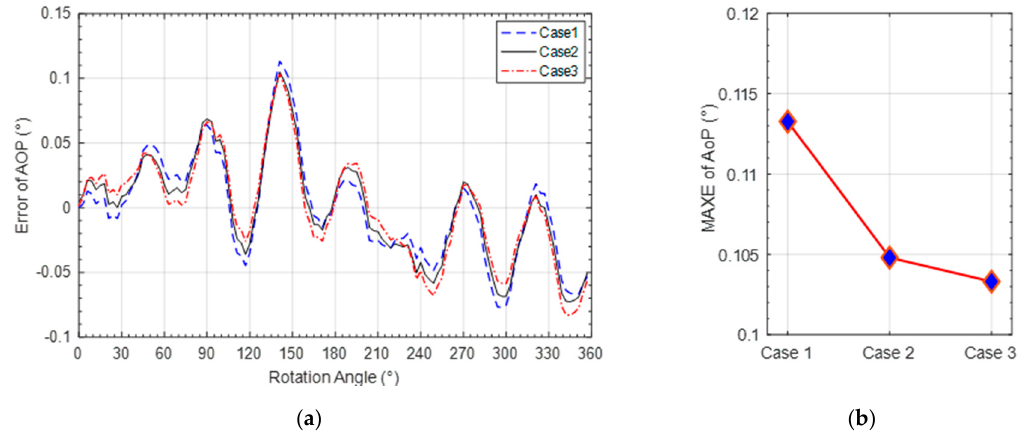
Figure 11. AOP-error comparison of three cases. ( a ) AOP-error curve comparison; ( b ) MAXE of AOP-error comparison. Table 5. Statistics comparison of AOP error.